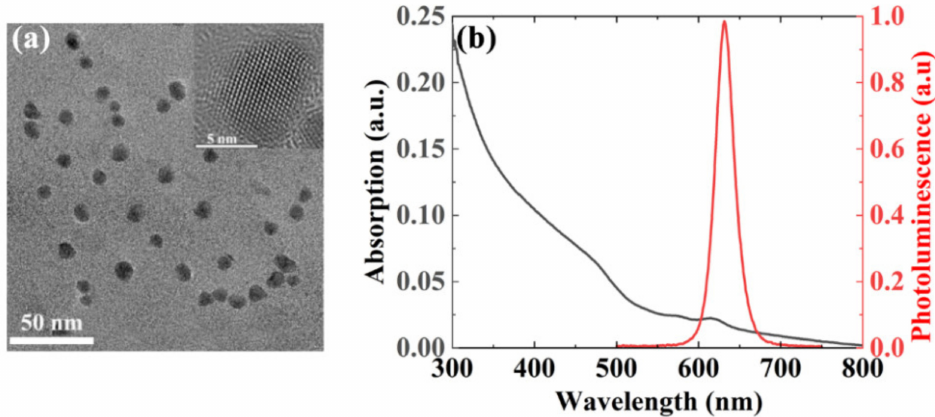
Figure 2. ( a ) TEM image of CQDs. The inset shows an HR-TEM image of the CQDs. ( b ) Absorption and photoluminescence spectra of the CQDs.